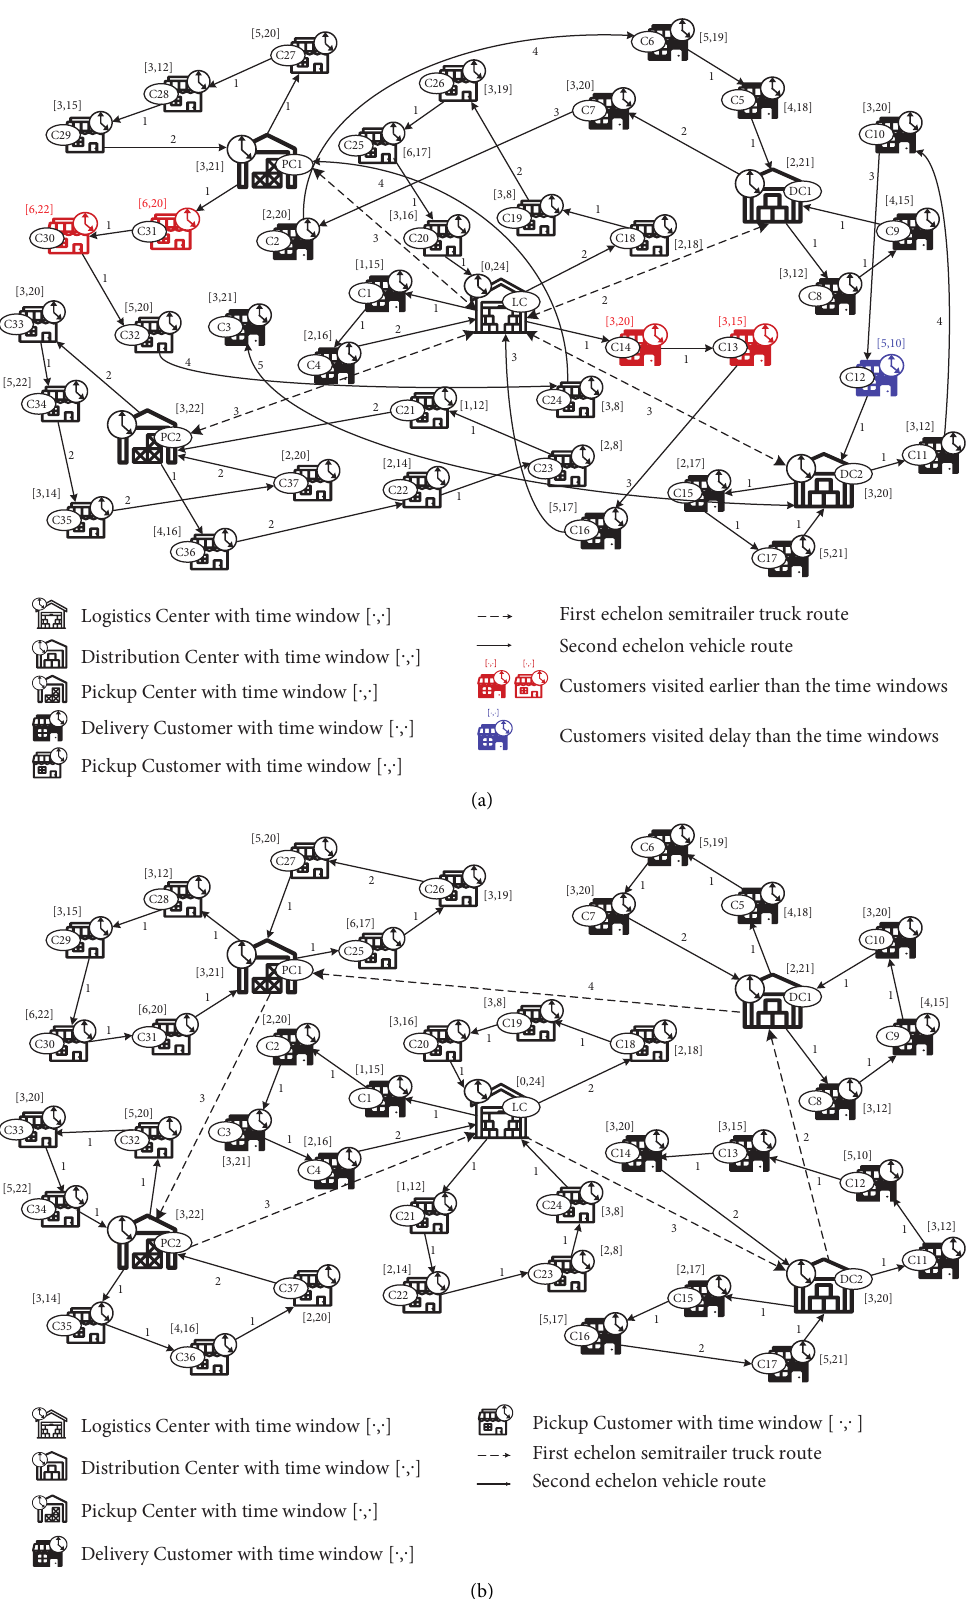
Figure 1: The 2E-LPDN before and after collaboration. (a) Two-echelon noncollaborative pickup and delivery network. (b) Two-echelon collaborative pickup and delivery